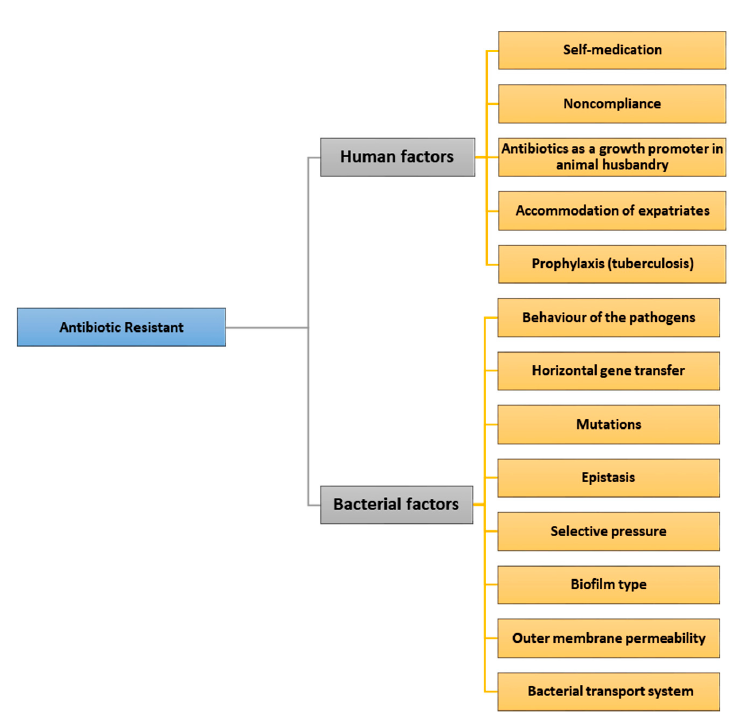
Fig. 1. shows factors that contribute to cause multidrug resistance